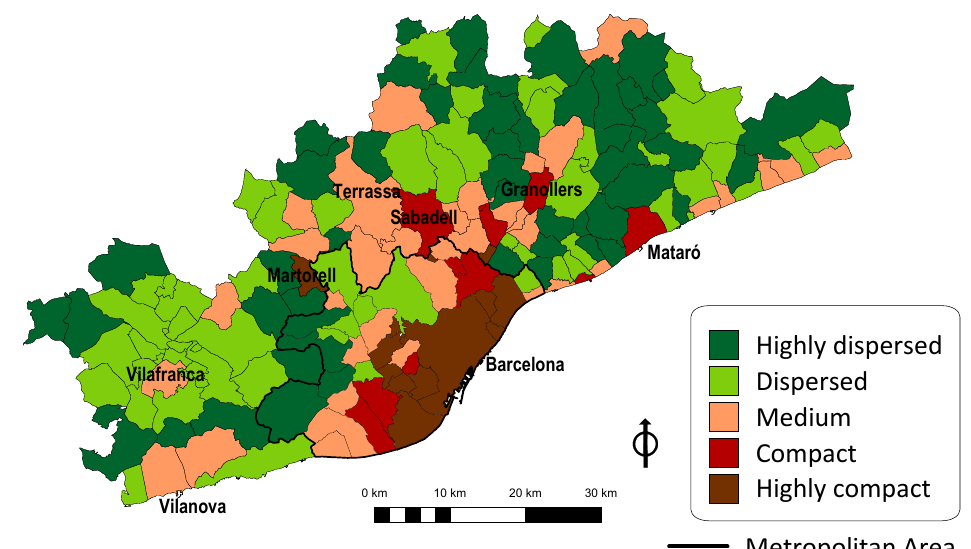
Figure 1. Classification of BMR municipalities by urban typology. Source: Compiled by the authors based on Censo de población (Population Census) 1991, Padrón Municipal de habitantes (Municipal Register of Inhabitants) 1996, and Padrón continuo (Continuous Register) 1998–2016, by the National Institute of Statistics (INE).